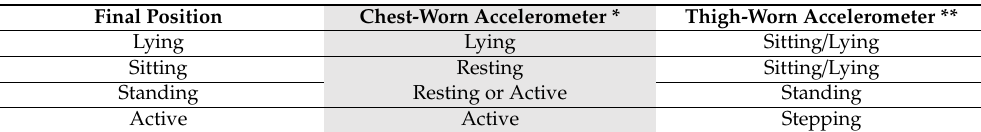
Table 1. Determination of position using data from two